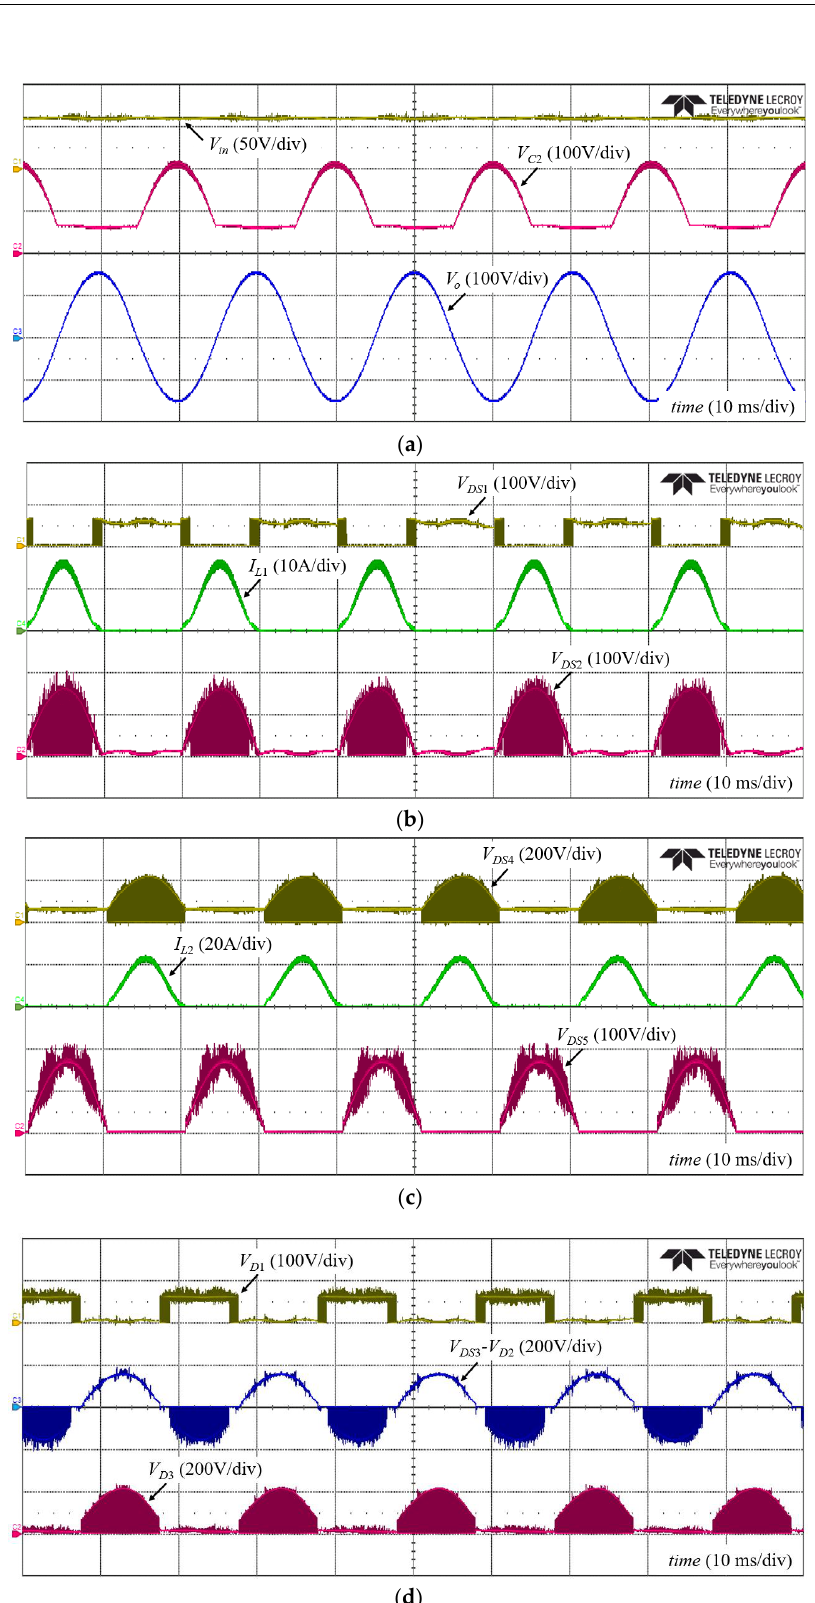
Figure 8. Experimental results with V in = 60 V. ( a ) the input, output and capacitor C 2 voltages, ( b ) the voltage stress on switches S 1 , S 2 , and the current of inductor L 1 , ( c ) the voltage stress on switches S 4 , S 5 , and the current of inductor L 2 , and ( d ) the voltage stress on diodes D 1 , D 2 , D 3 and the voltage stress on switch S 3 .